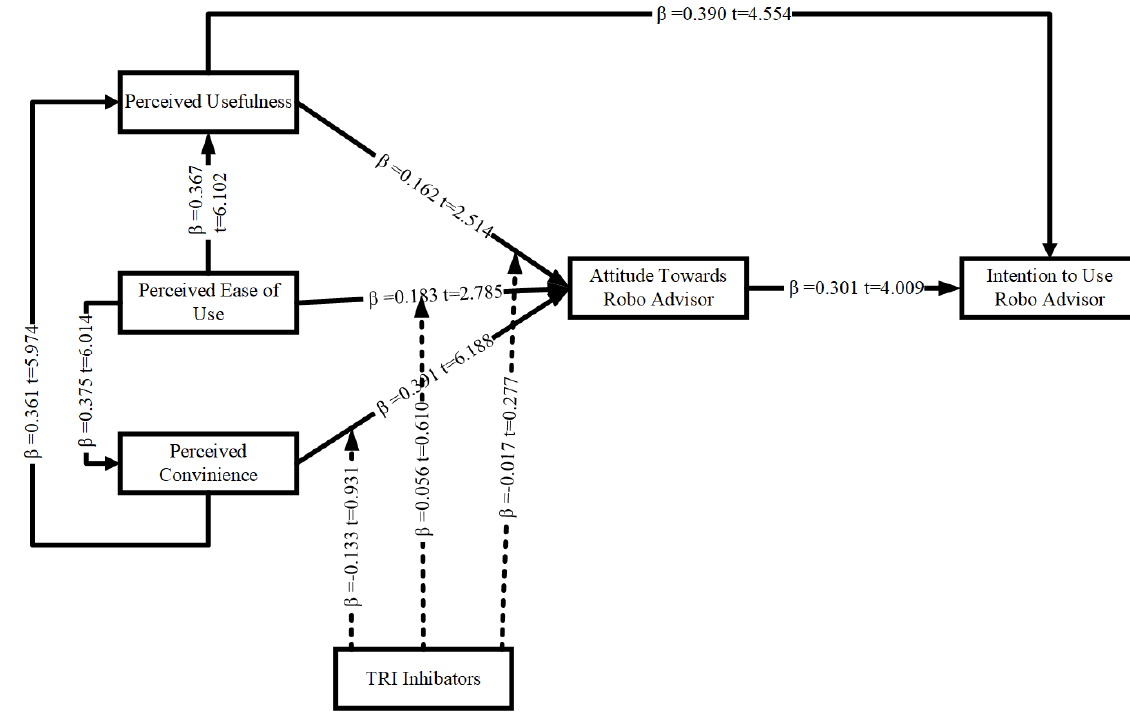
Figure A4. Moderating Effects of TRI Inhibitors . Table A1. Demographic Characteristics of Respondents, N = 208.